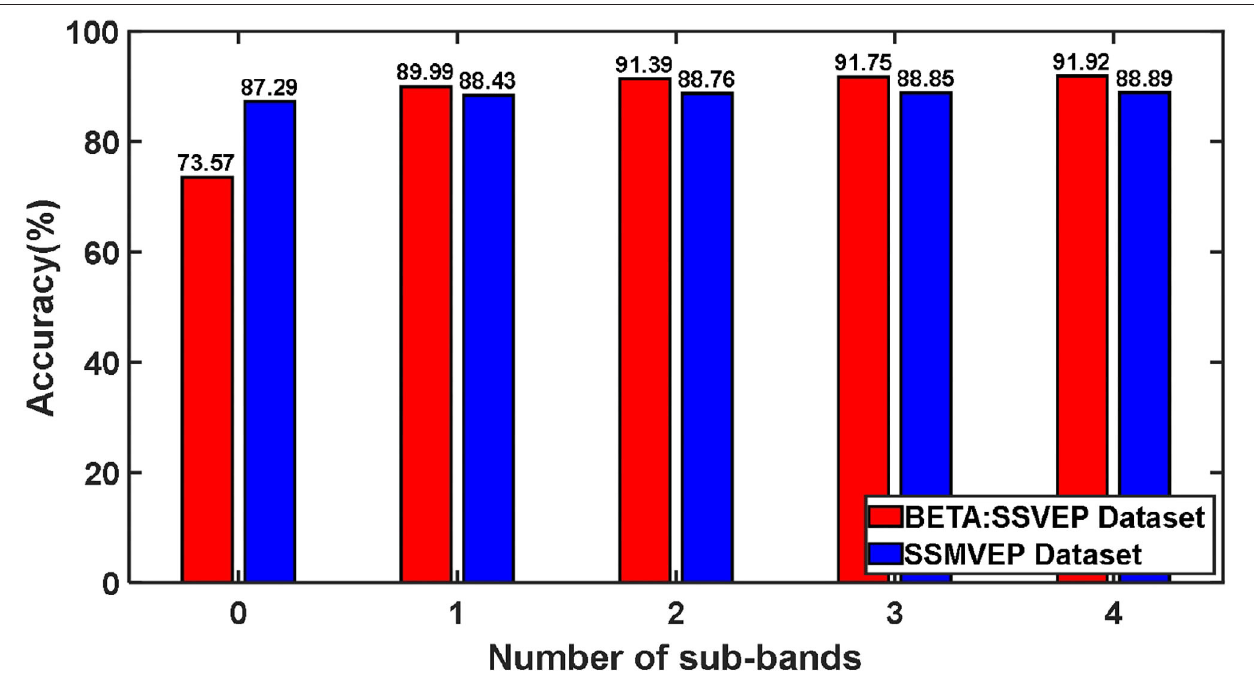
FIGURE 10 | The influence of different harmonic frequency band numbers on the ZPFDCNN